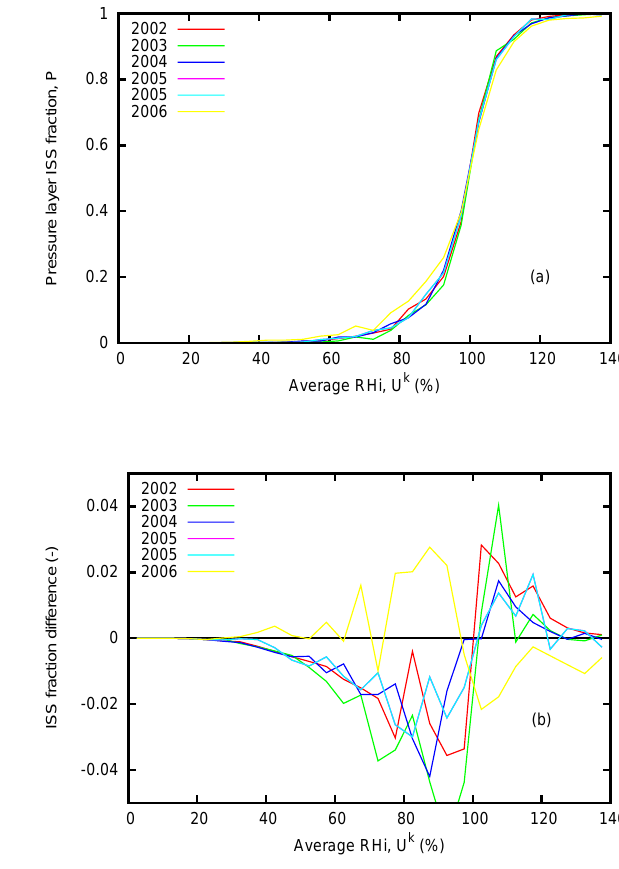
Fig. 7. The relationship between average RHi and the ISS fraction for the 250–300-hPa pressure layer is shown. Panel (a) shows the s-shaped relationships for each station and panel (b) shows the difference between curves from each station and the British Isles average s-shaped relationship. These data are from six high resolution radiosonde launch stations within the British Isles (January 2002–December 2006).